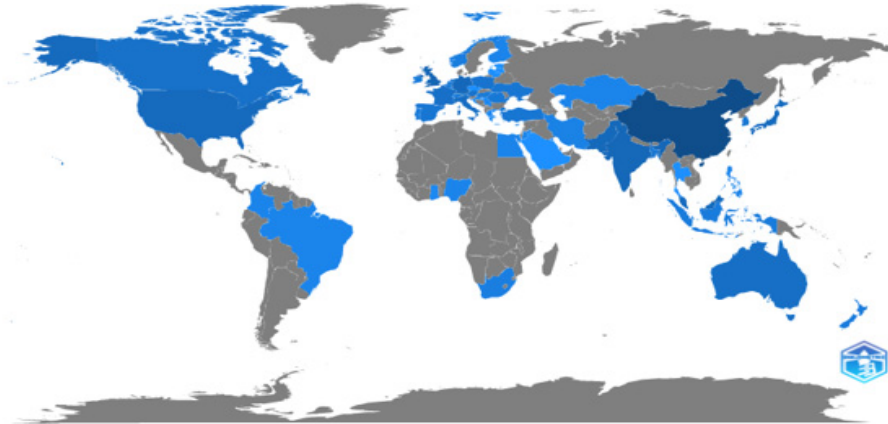
Figure 5. Scientific distribution across the globe.